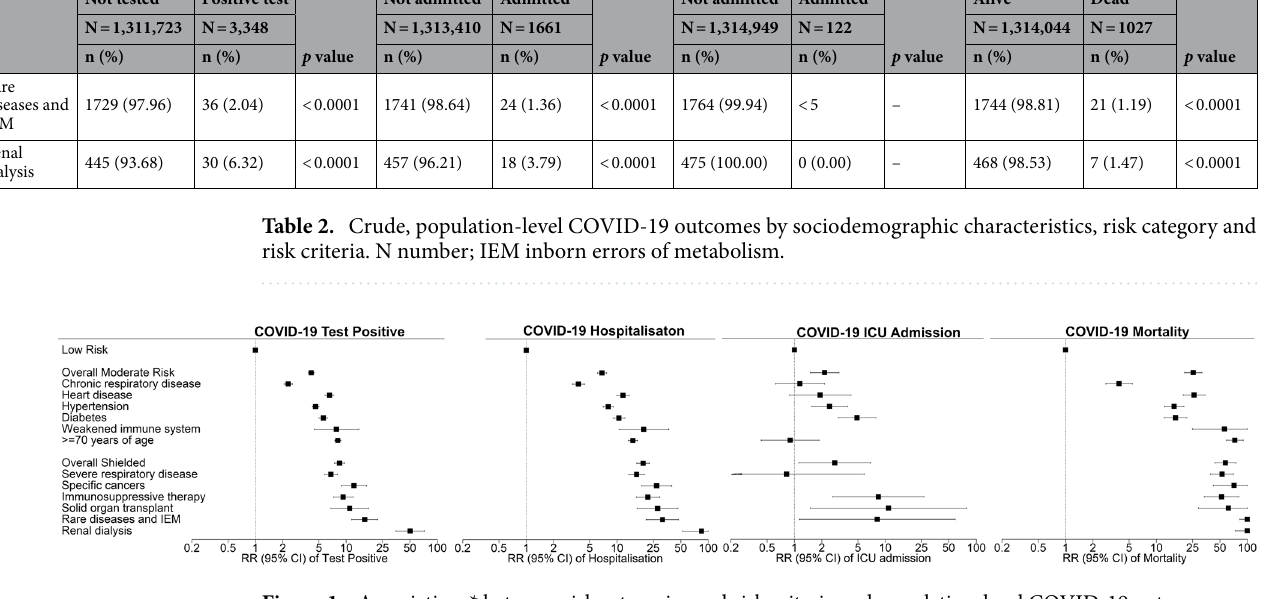
Figure 1. Associations* between risk categories and risk criteria and population-level COVID-19 outcomes. *Adjusted for sex, deprivation quintile, and other risk categories. RR relative risk; CI confidence interval; IEM inborn errors of